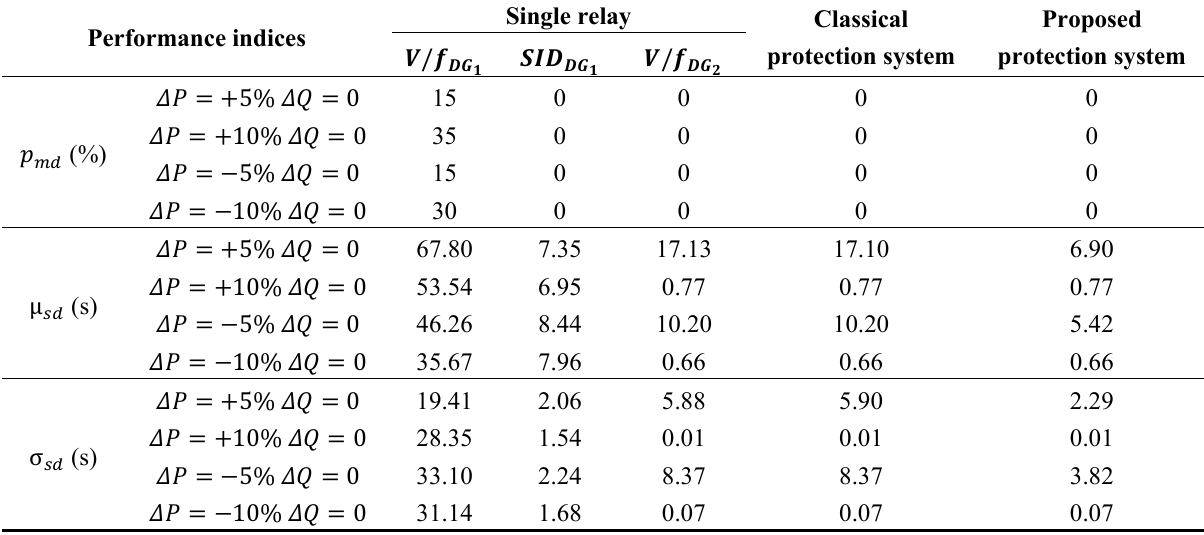
Table 13. Comparison between the classical and the proposed protection systems in the Case C. Single relay Classical Performance indices protection system